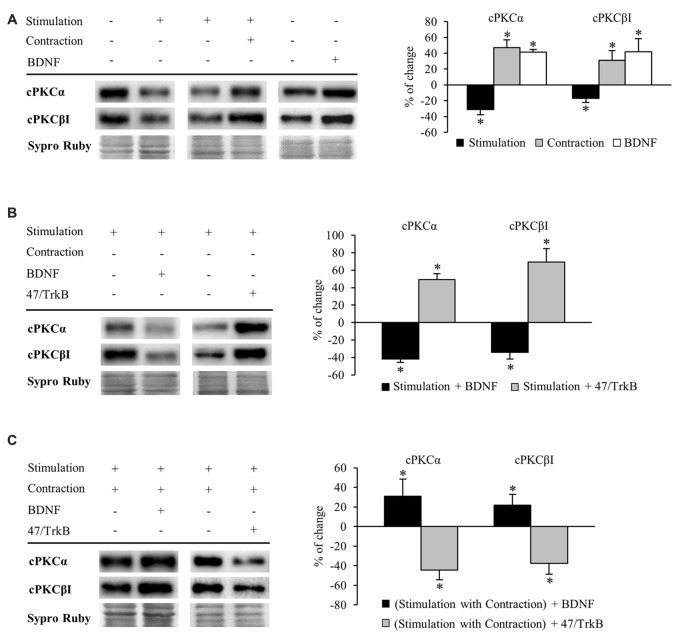
Synaptic activity and muscle contraction modulates cPKC isoforms through BDNF/TrkB signaling. Panels (A–C) show Western blot bands and their quantification. (A) cPKC isoforms α and βI in presynaptic stimulation treatment and contraction treatment at 1 Hz stimulation for 30 min. cPKC α and βI in basal conditions with exogenous BDNF for 30 min. Presynaptic stimulation has been simplified as Stimulation. Each column has been compared to its respective control (see Table 1). Results show that presynaptic stimulation decreased the levels of cPKC α and βI whereas muscle contraction increased them. In basal conditions, exogenous BDNF increased the levels of cPKC α and βI. (B) Effect of exogenous BDNF (10 μM) and 47/TrkB (10 μg/ml) on cPKC isoforms α and βI in presynaptic stimulation treatment. BDNF enhanced the effects of presynaptic stimulation, decreasing cPKC levels, and conversely, 47/TrkB increased them. (C) Effects of exogenous BDNF (10 μM) and 47/TrkB (10 μg/ml) on cPKCα and cPKCβI in presynaptic stimulation with contraction treatment. BDNF enhanced the effects of presynaptic stimulation with contraction treatment, increasing cPKC levels, and conversely, 47/TrkB decreased them. Data are mean percentage ± SEM, *p < 0.05. Abbreviations: cPKCα, conventional Protein Kinase C (PKC) α; cPKCβI, conventional PKC βI.